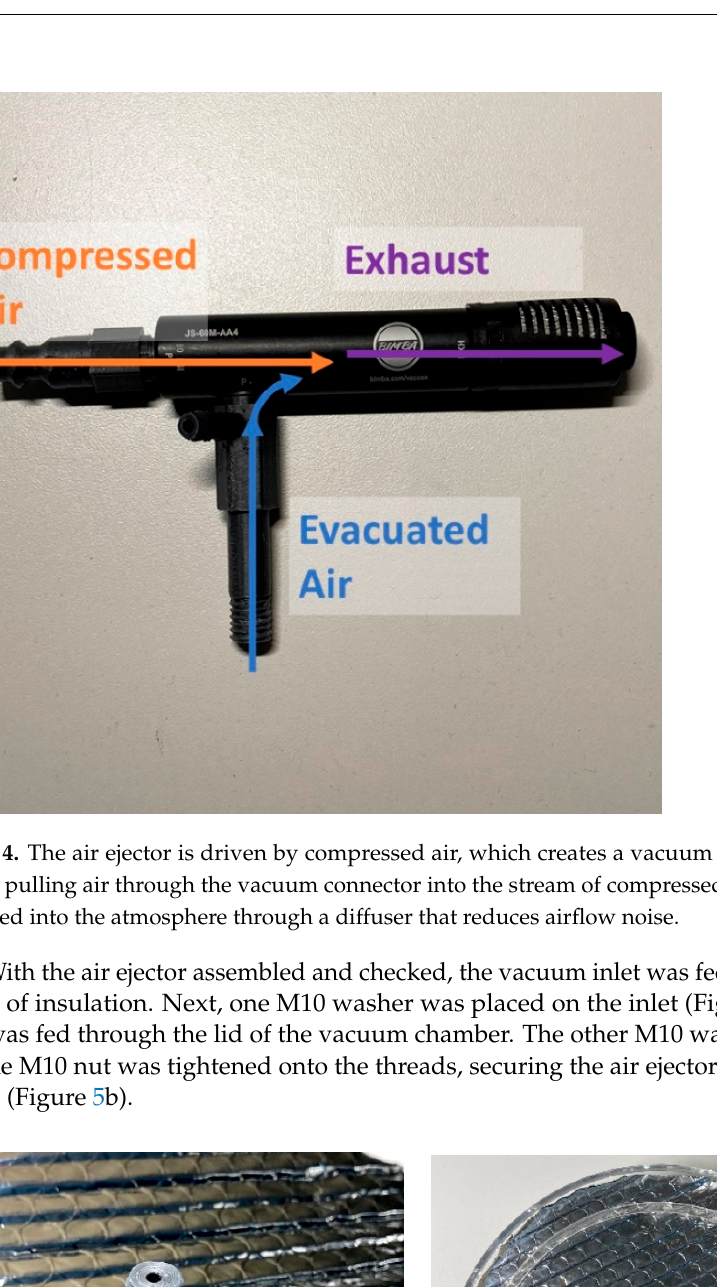
Figure 3. Assemble the air ejector. ( a ) Thread the 3-D printed connectors into the air ejector, using PTFE tape if necessary; ( b ) attach the vacuum gauge to the hose barb. Note that the same parts were printed in orange (left) and grey (right) PLA.